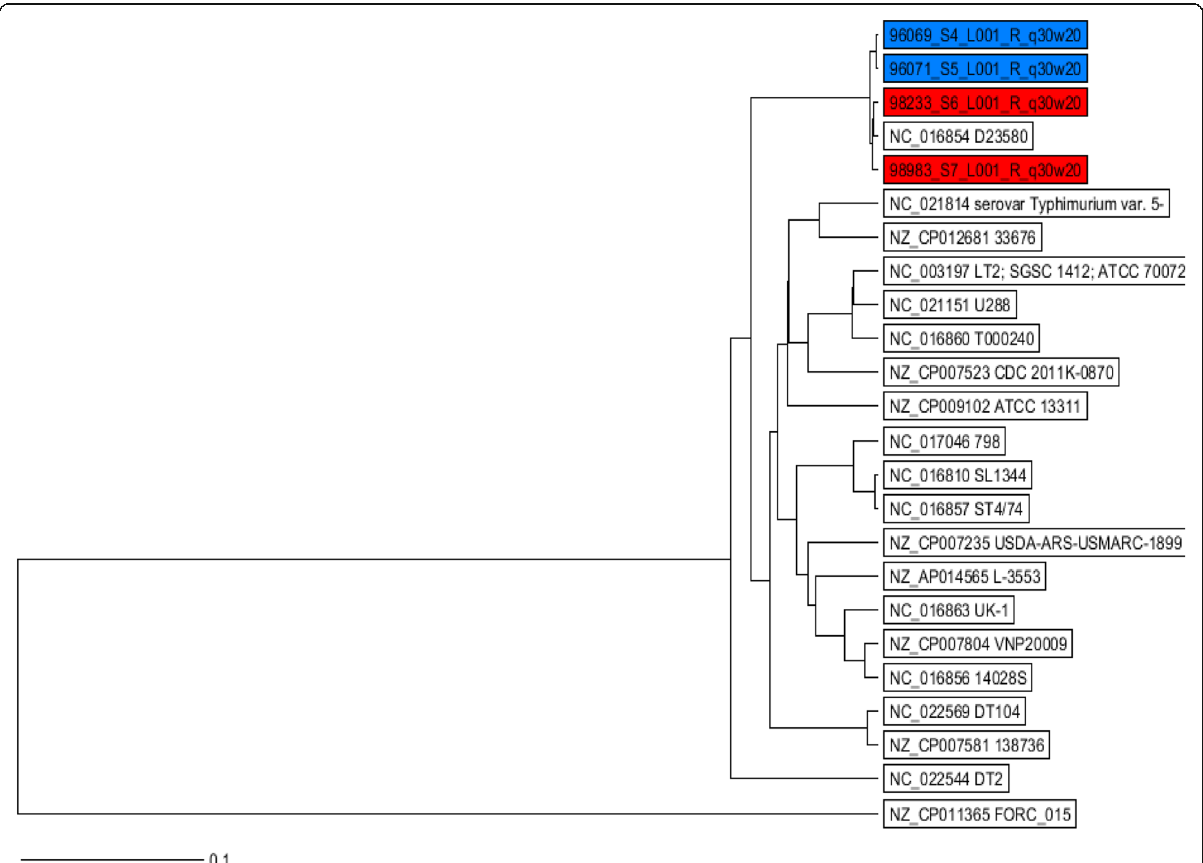
Fig. 1 UPGMA tree showing comparison of the MLST sequences of four Burkinabe and 20 reference strains. The tree is based on 3214 columns, no missing values, and % column difference. The human isolates from Burkina Faso are highlighted with blue and chicken isolates with